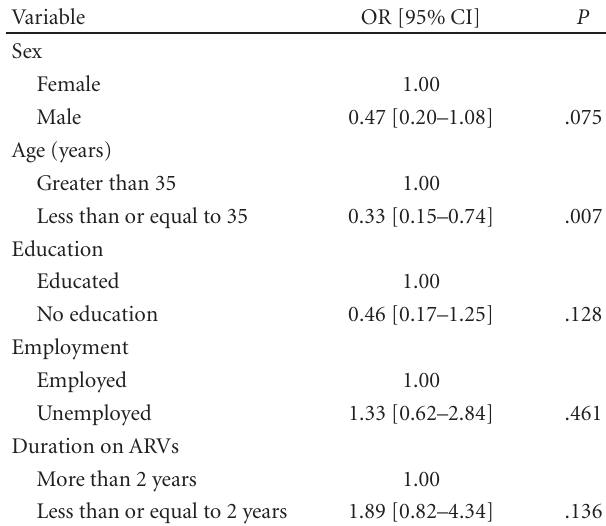
Table 5: Multivariate logistic regression analysis to determine predictors of regular clinic